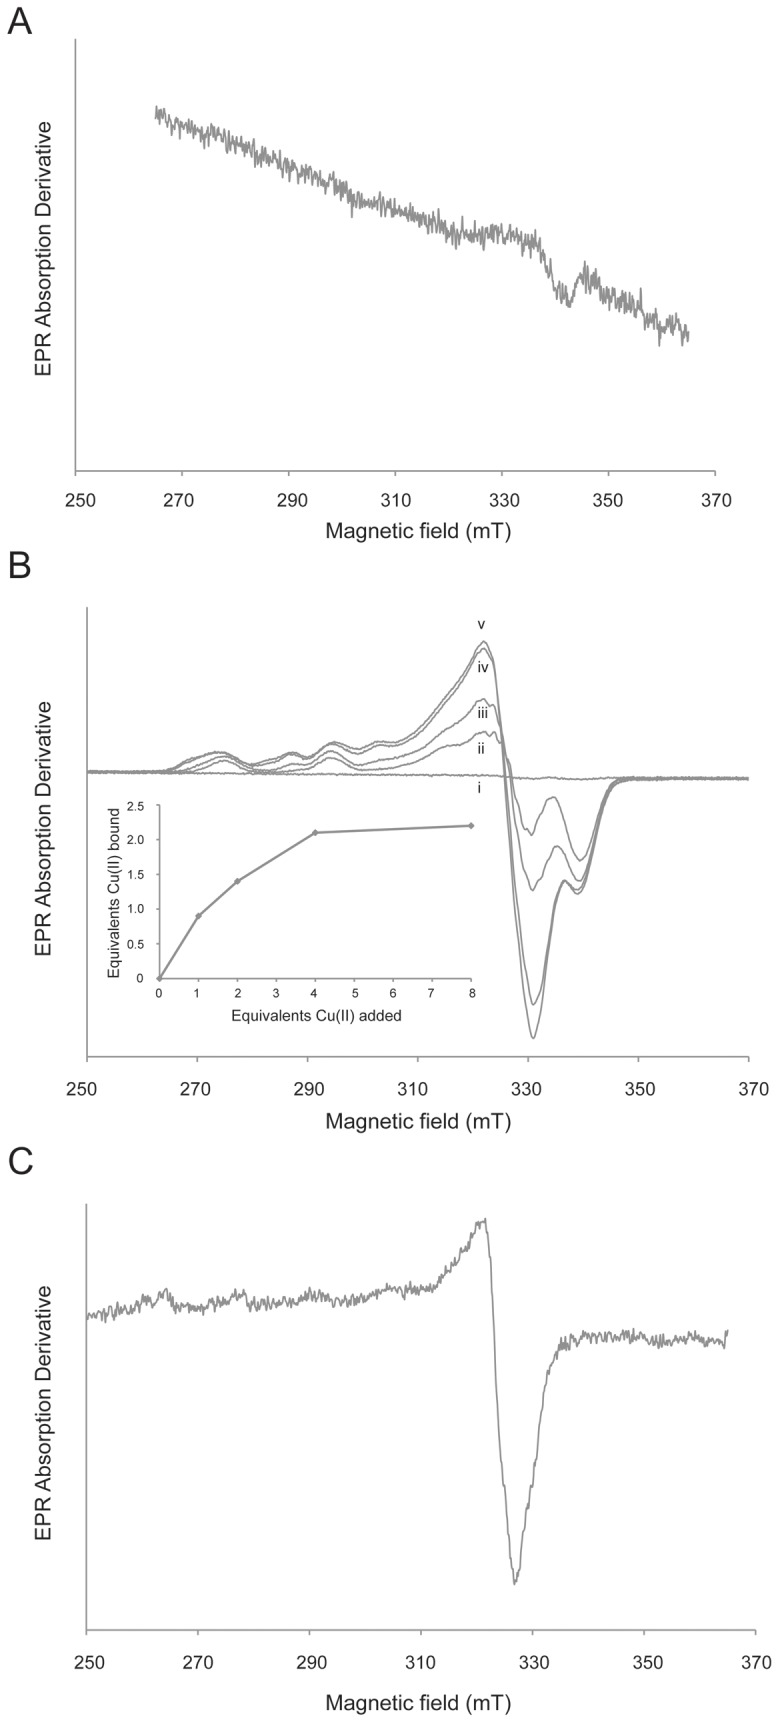
EPR analysis of MopE*.A) EPR spectrum of Mops buffer with 1 mM CuCl2. The spectrum was recorded at a temperature of 77 K with a modulation frequency of 100 kHz, a modulation amplitude of 1.0 mT; and a time constant of 164 ms. The microwave frequency was 9.57 GHz, and the microwave power was 1 mW. B) EPR spectra of MopE* (360 uM) as purified (i), and with 1, 2, 4, and 8 (ii–v) molar equivalents of Cu(II) respectively. Copper was added as CuCl2 from a freshly prepared solution in water. The spectra were recorded at 33 K, a modulation frequency of 100 kHz, a modulation amplitude of 0.6 mT, a time constant of 41 ms, a microwave frequency of 9.37 GHz, and a microwave power of 0.1 mW. The inset shows EPR-detected Cu(II) as a function of added Cu(II), demonstrating near saturation after addition of 4 molar equivalents of Cu(II). C) EPR spectrum of MopE* after treatment with 2.5% nitric acid. The spectrum was recorded at a temperature of 27 K, a modulation amplitude of 0.6 mT, a time constant of 40,960 ms, a microwave frequency of 9.39 GHz, and a microwave power of 0.05 mW.